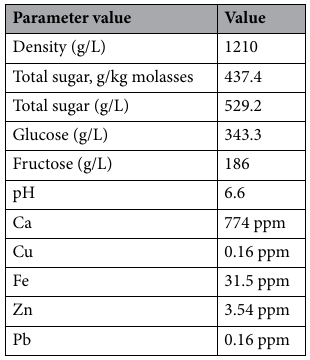
Table 2. Characteristics of sugar beet